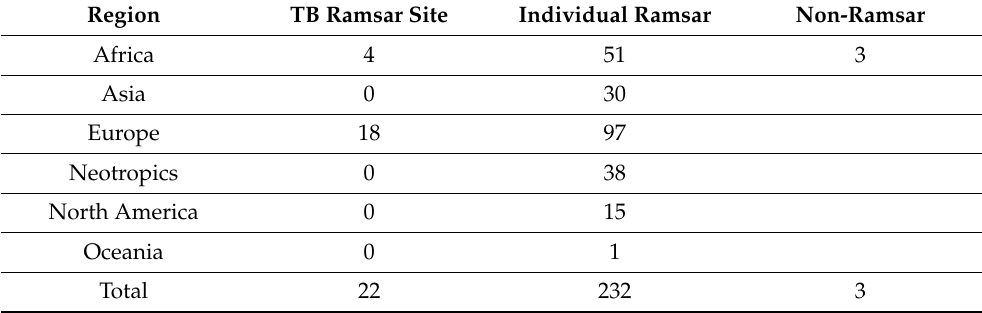
Table 6. Regional distribution of transboundary (TB) wetlands by Ramsar designation status (non- Ramsar only includes the limited number documented in this